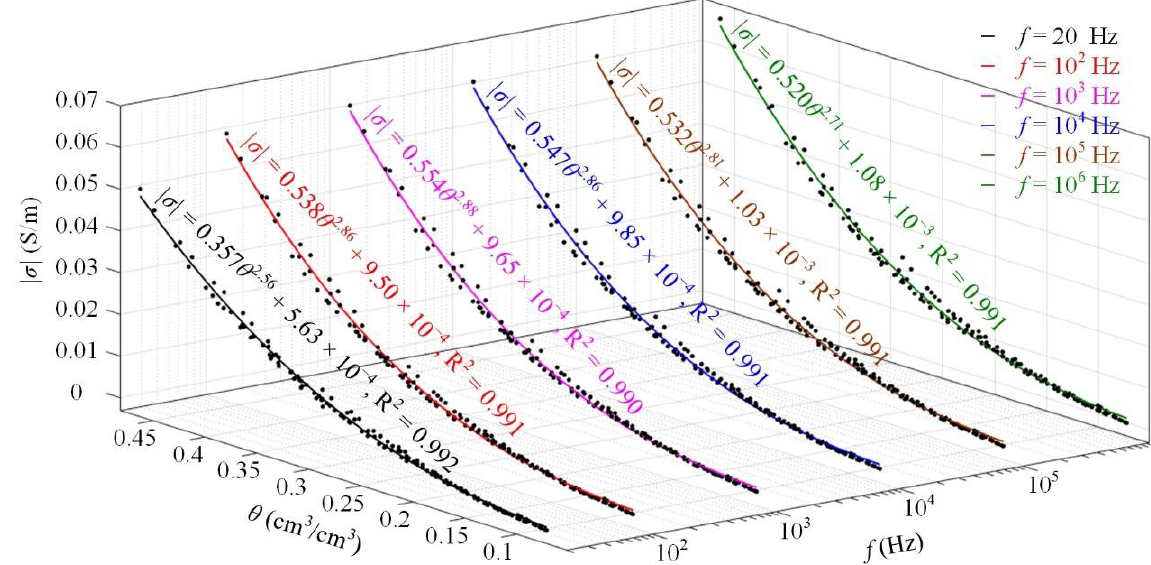
Figure A7. Fitted relations between substrate conductivity magnitude and volumetric water content at different frequencies for the substrates with certain variability in dry density. The mean and standard deviation of the dry densities (Table S1) are 0.455 g/cm 3 and 5.04 × 10 −2 , respectively.